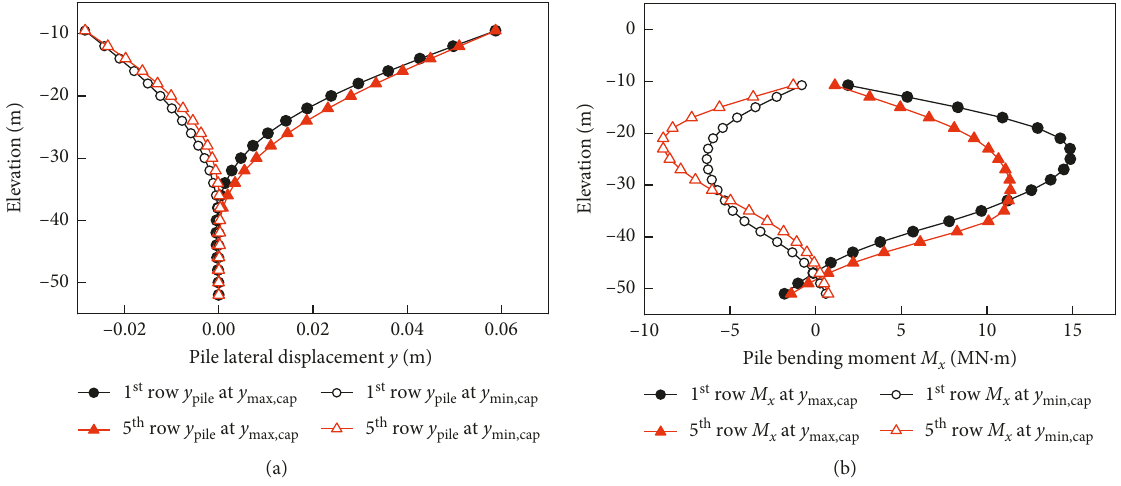
st and 5 th rows. (b) Pile bending moment